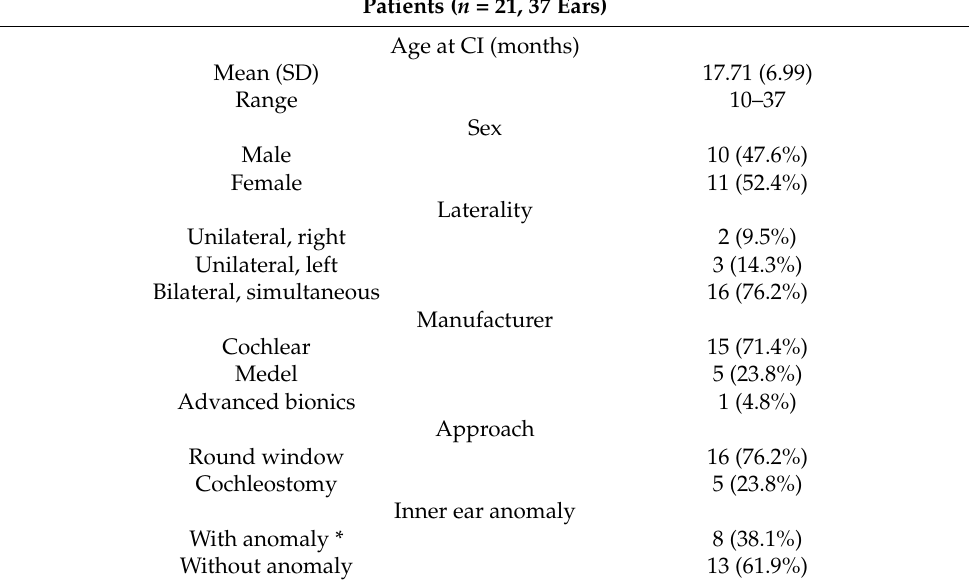
Table 1. Demographics and clinical characteristics of pediatric cochlear implantees with cochlear nerve aplasia. Patients ( n = 21, 37 Ears) Age at CI (months) Mean (SD) 17.71 (6.99)